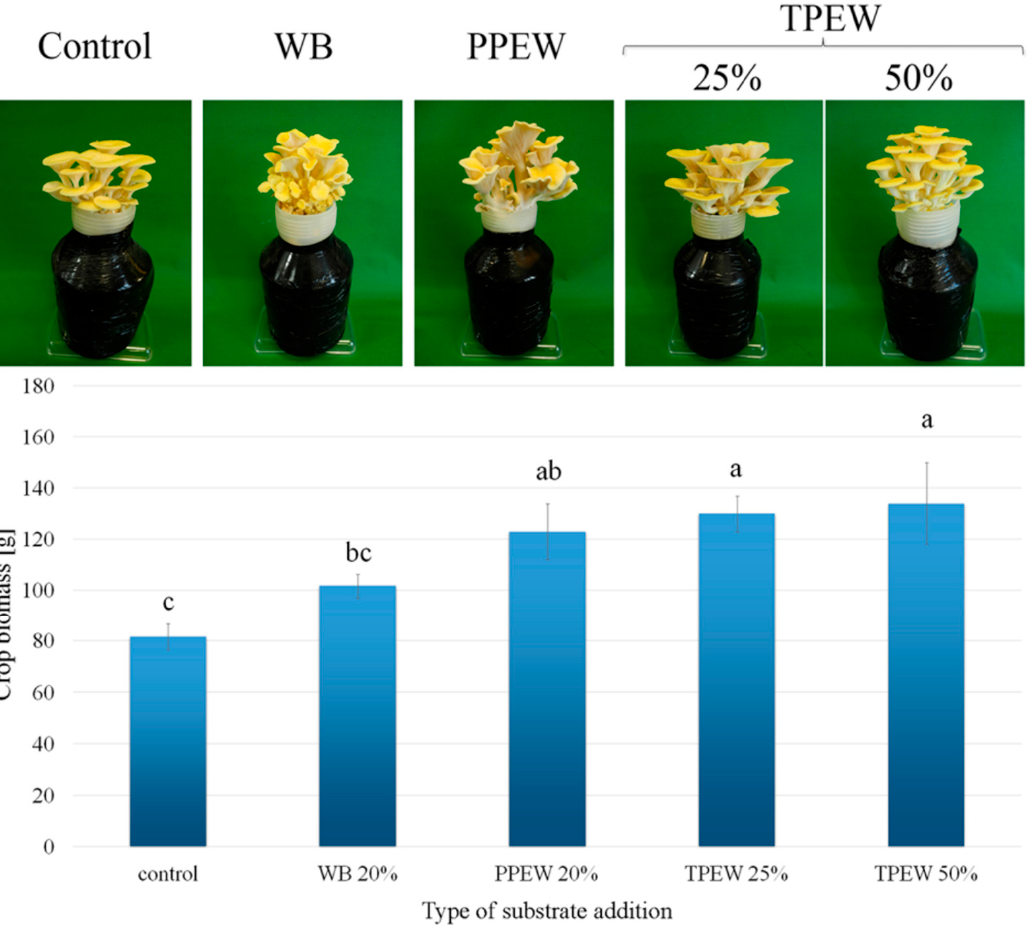
Figure 1. Morphology and biomass crop (g) of Pleurotus citrinopileatus growing under particular additions to substrate. Mean values ( n = 3); identical superscripts ( a,b,c ) denote no significant ( p < 0.05) difference between mean values in columns according to Tukey’s HSD test (ANOVA) for mushrooms growing at particular substrates. WB—wheat bran, PPEW—pumpkin post-extraction waste, TPEW—thymus post-extraction waste.